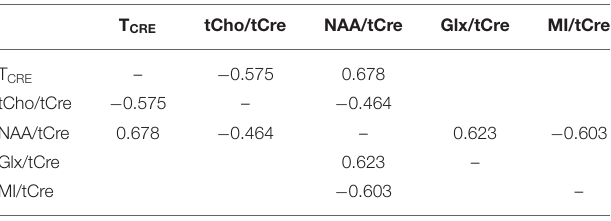
TABLE 4 | Spearman correlations between metabolite ratios and brain temperature. COVrep (%)